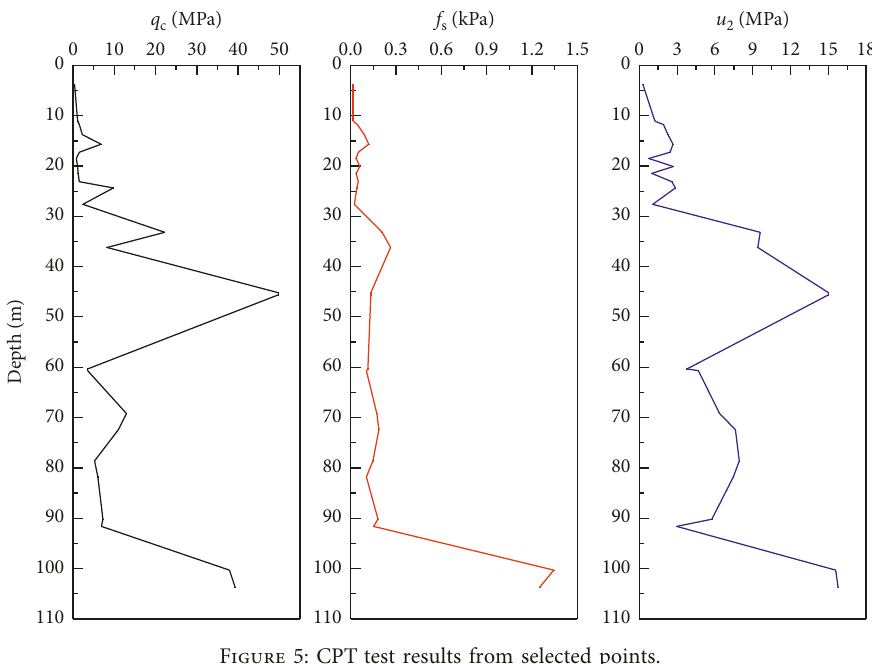
Figure 5: CPT test results from selected